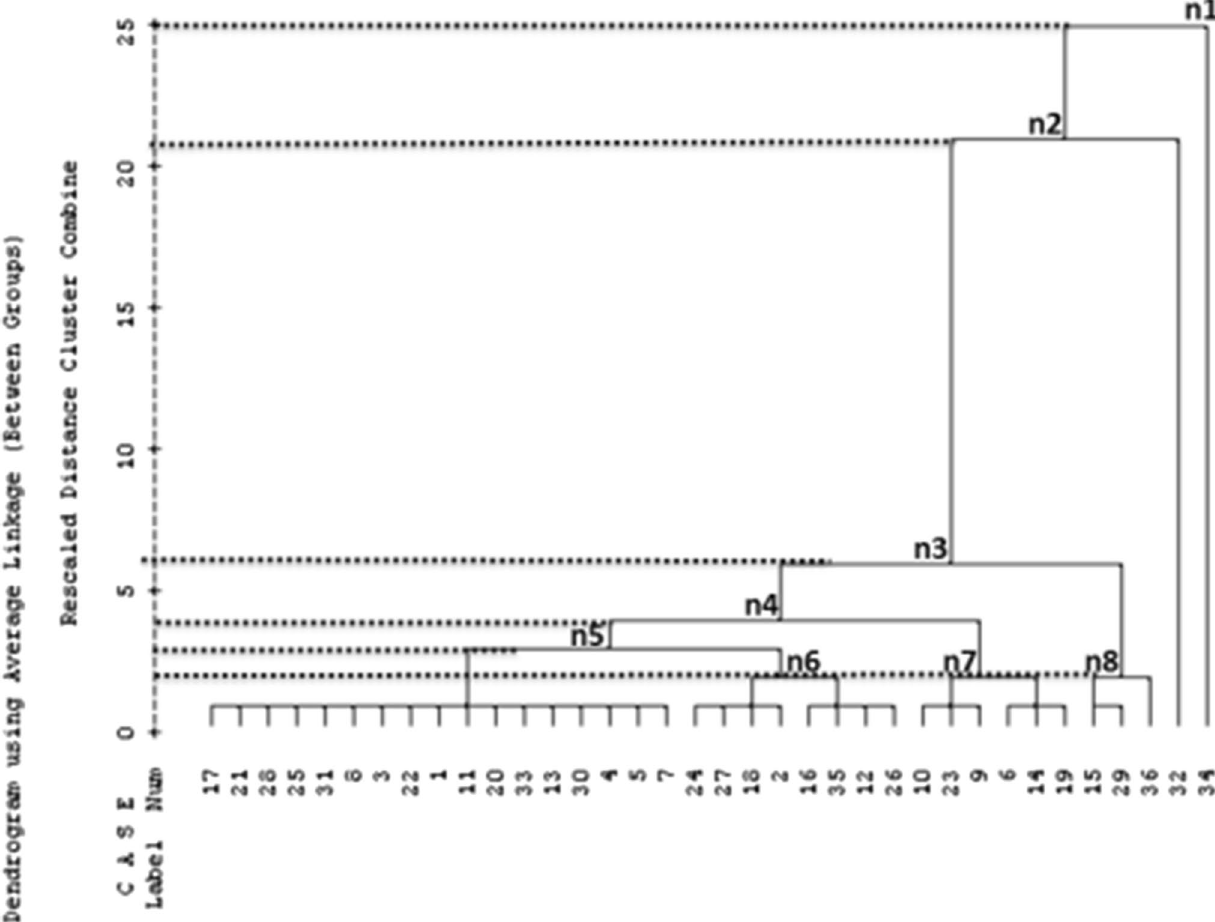
Fig. 4 Dendrogram of the clustered watersheds in the study